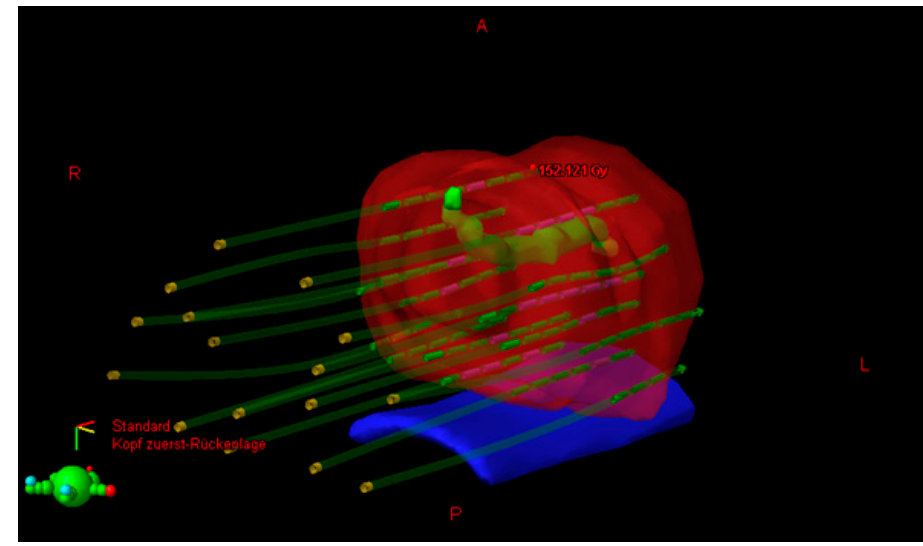
Figure 2. Three-dimensional image with simulation of radiation (red: prostate, green: urethra, blue: rectum, dark green: needle positions).